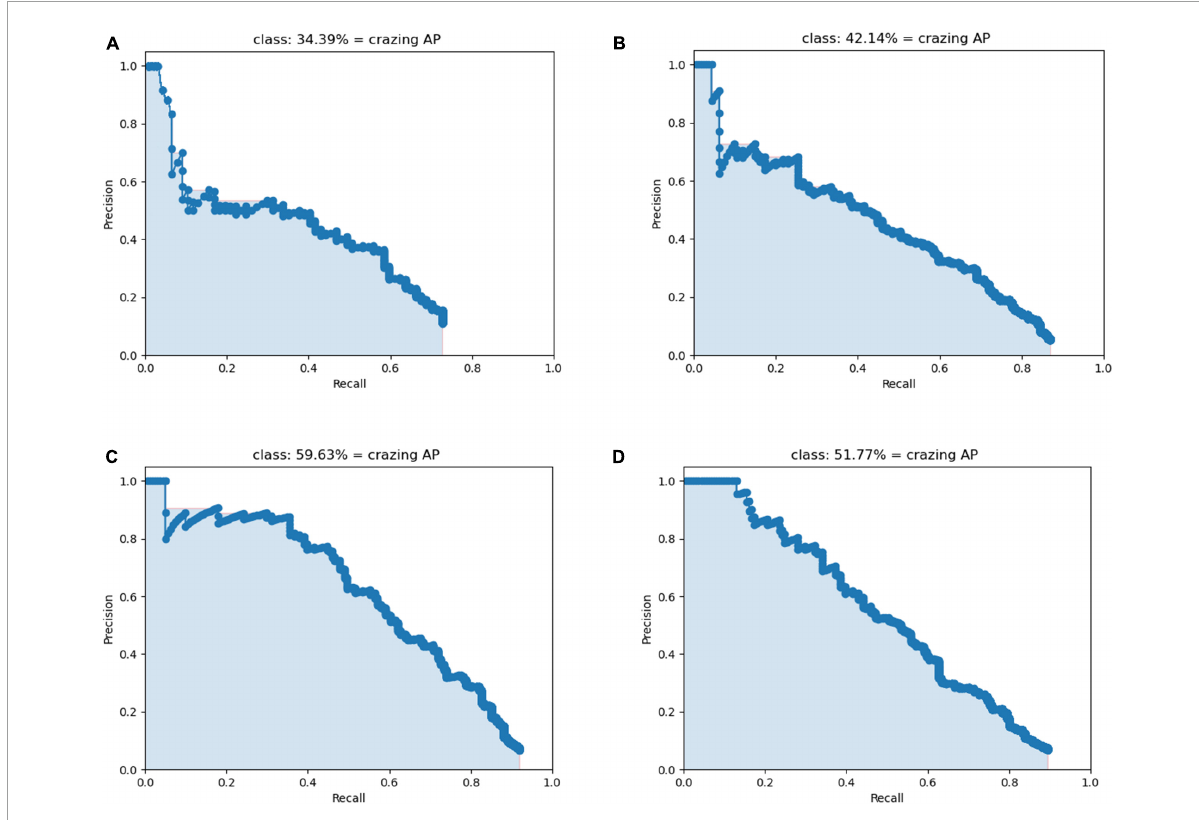
FIGURE9 P-R diagram of Crazing. (A) Scenario 0. (B) Scenario 1. (C) Scenario 2. (D) Scenario 3.